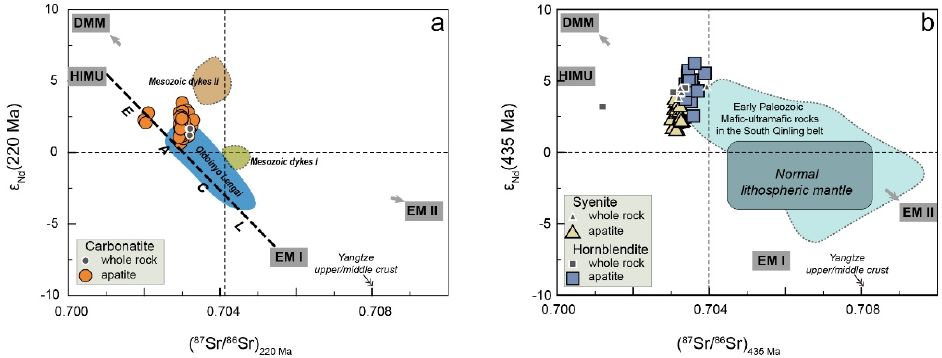
Figure 4. Sr–Nd isotopic diagram for the SXD Triassic carbonatite ( a ) and early Paleozoic horn- blendite–syenite intrusion ( b ). The data of Mesozoic dykes are from Nie et al. [46] . The East African carbonatite line (EACL) and Oldoinyo Lengai are referred to in [57–59] . The normal lithospheric mantle is constrained by the Early Paleozoic mafic dykes in South Qinling [60,61]. The Yangtze up- per/middle crust data are from Chen and Jahn [62] , Gao et al. [63] , and Ma et al. [64] . The data of the early Paleozoic mafic-ultramafic rocks in the South Qinling Belt are from [65] .